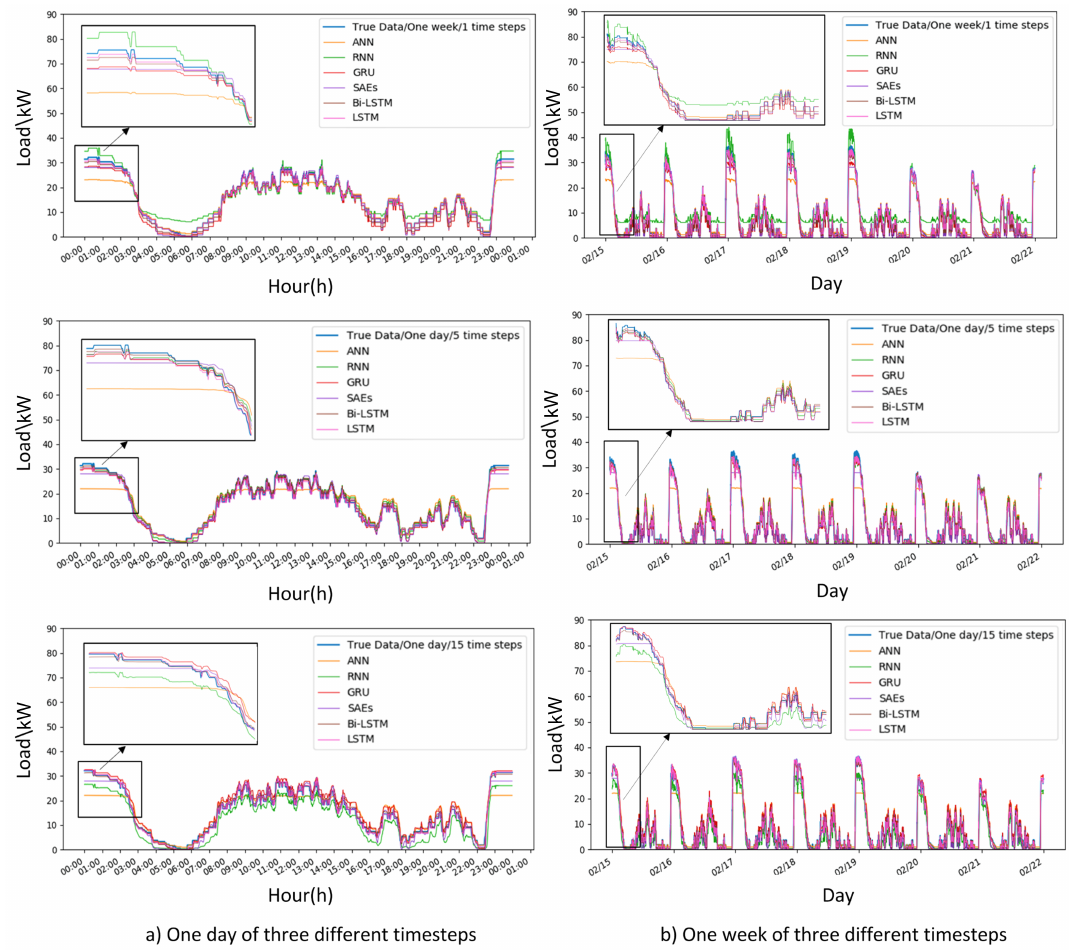
Figure 11. Different time steps load forecasting curve effect comparison graph of one